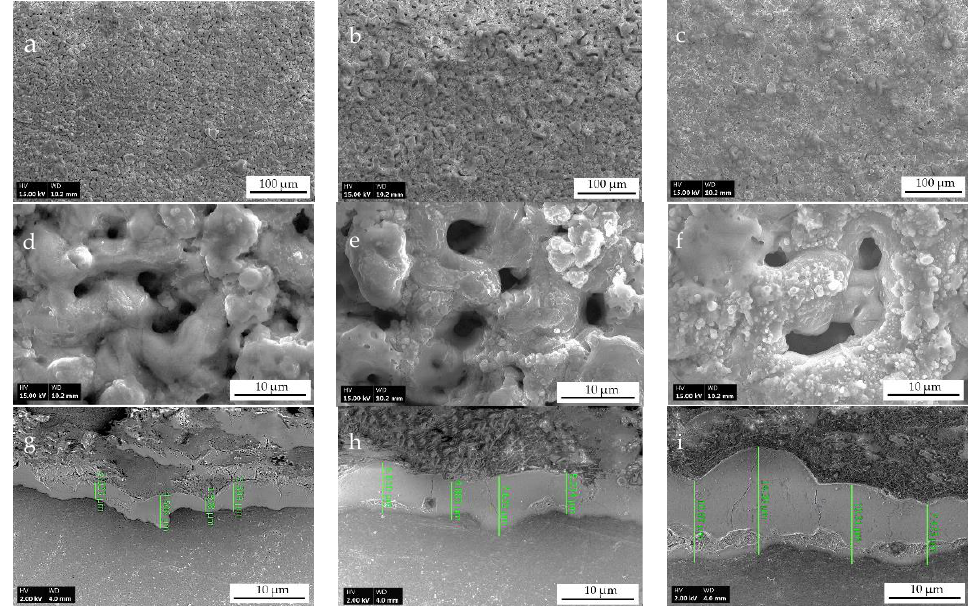
Figure 1. Surface morphology views and cross-sectional scanning electron microscopy images of the PEO coating formed at different process parameters: AA-4 ( a , d , g ); AA-8 ( b , e , h ); AA-12 ( c , f , i ).